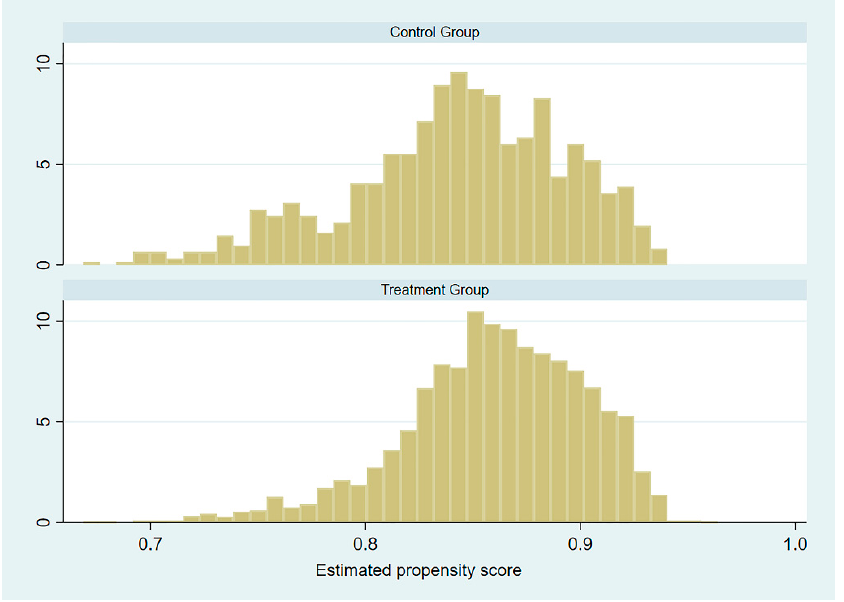
Figure 1. Propensity score histograms.